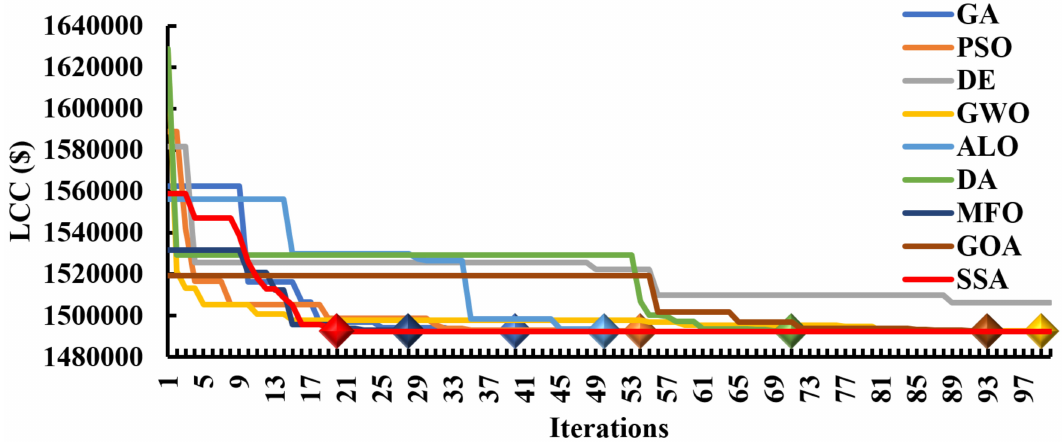
Figure 19. Convergence curves of LA at 80% DOD with HPRALC.